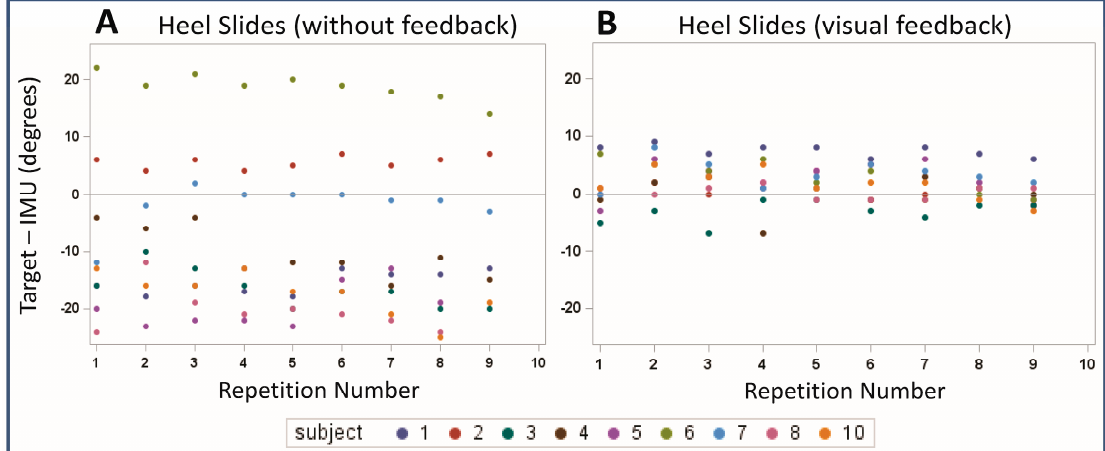
Figure 3. Scatterplot of the difference between the target ROM value of 60 degrees and the actual ROM for ( A ) the heel slides without visual feedback and ( B ) the heel slides with visual feedback.